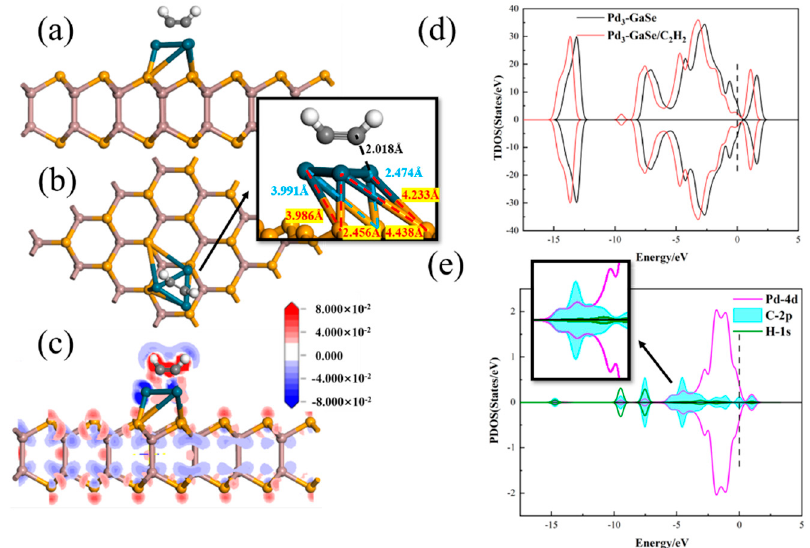
Figure 12. Adsorptive structure of Pd 3 -GaSe/C 2 H 2 system ( a ) view of side, ( b ) view of top, ( c ) DCD distribution, ( d ) TDOS of Pd 3 -GaSe/ C 2 H 2 system, ( e ) PDOS of Pd 3 -GaSe/ C 2 H 2 system.